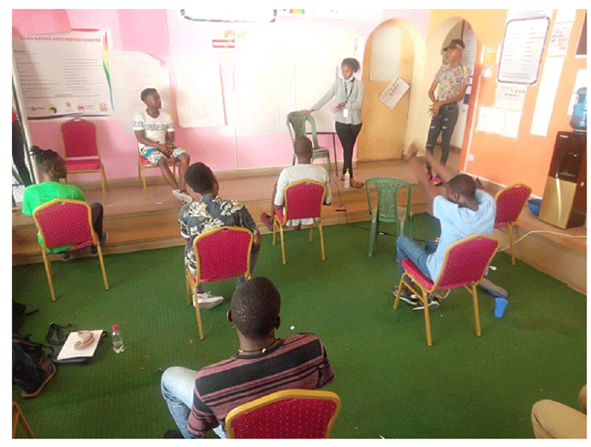
Figure 4. Intensive COVID-19 training conducted in HAPA Kenya offices, Mombasa.